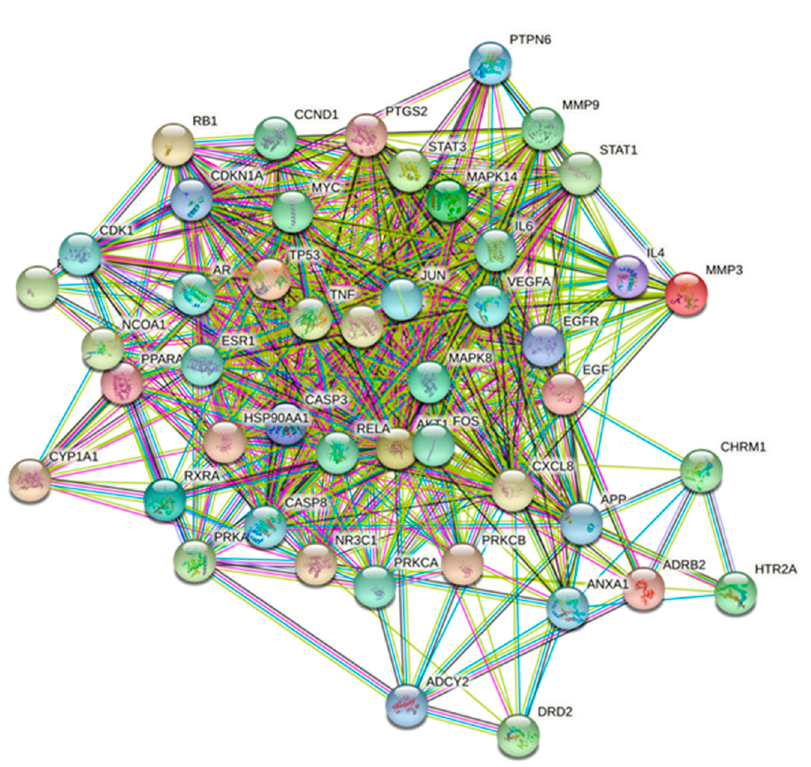
Figure 2. PPI (protein-protein interaction) network of 47 key targets of SCH compounds. In total, 47 nodes of key targets and 284 edges of interaction are represented.